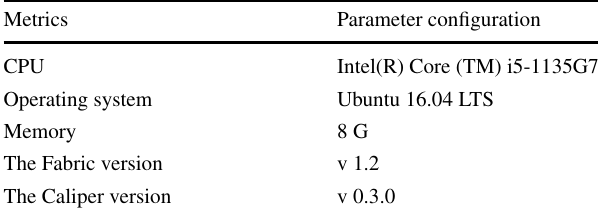
Table 15 Experimental environment configuration